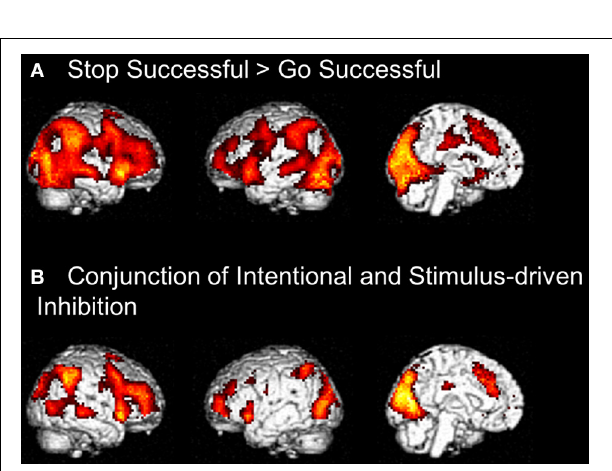
FIGURE 6 | (A) Whole brain contrast showing activation related to stimulus-driven inhibition process (Stop Successful > Go Successful) (FDR-corrected p < 0 . 05, at least 10 contiguous voxels). (B) Conjunction analysis showing overlapping activation in intentional inhibition process (White NoGo > Green Go) and stimulus driven inhibition process (Stop Successful > Go Successful) (FDR-corrected p < 0 . 05, at least 10 contiguous